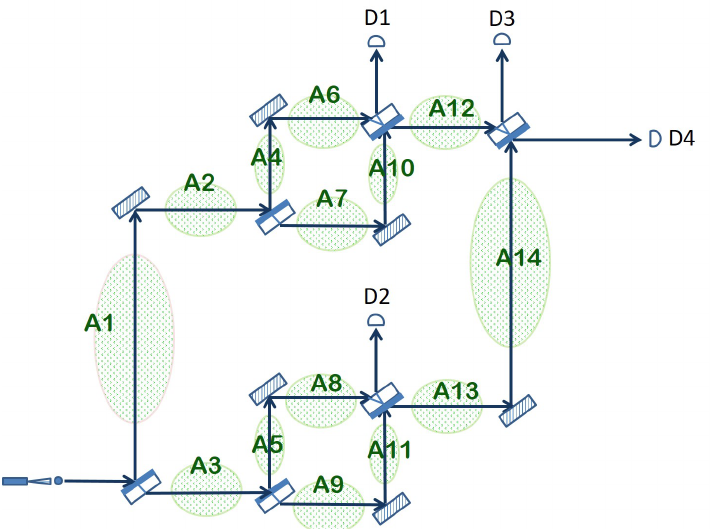
Figure 3. Extended quantum sensor obtained by placing an additional Mach–Zehnder interferometer in each of the two arms of the original